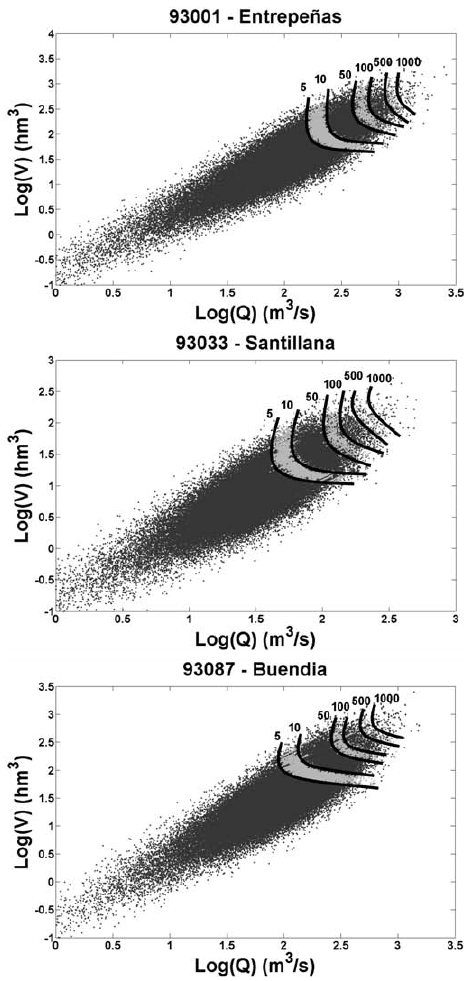
Fig. 7. Return period curves from the maximum reservoir level at- tained during the routing process.